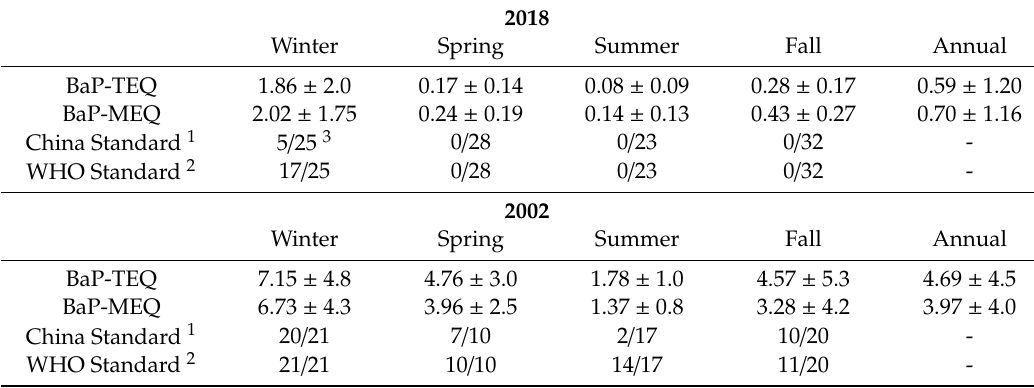
Table 9. Seasonal and Annual average toxicity evaluation of PAHs in 2002 and 2019 (unit: ng m − 3